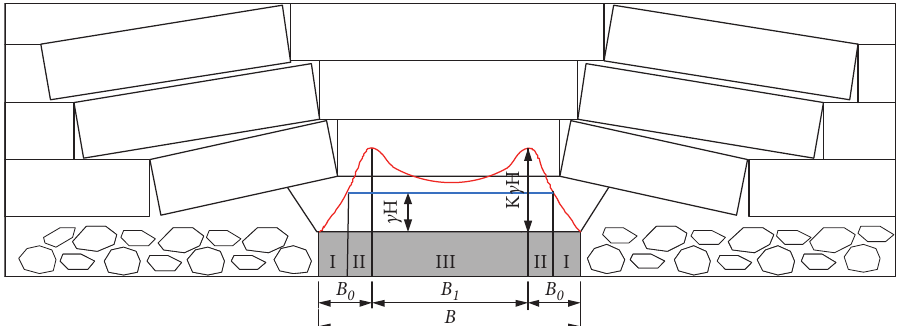
Figure 4: Structural model of the elastic-plastic zone of the residual coal pillar.